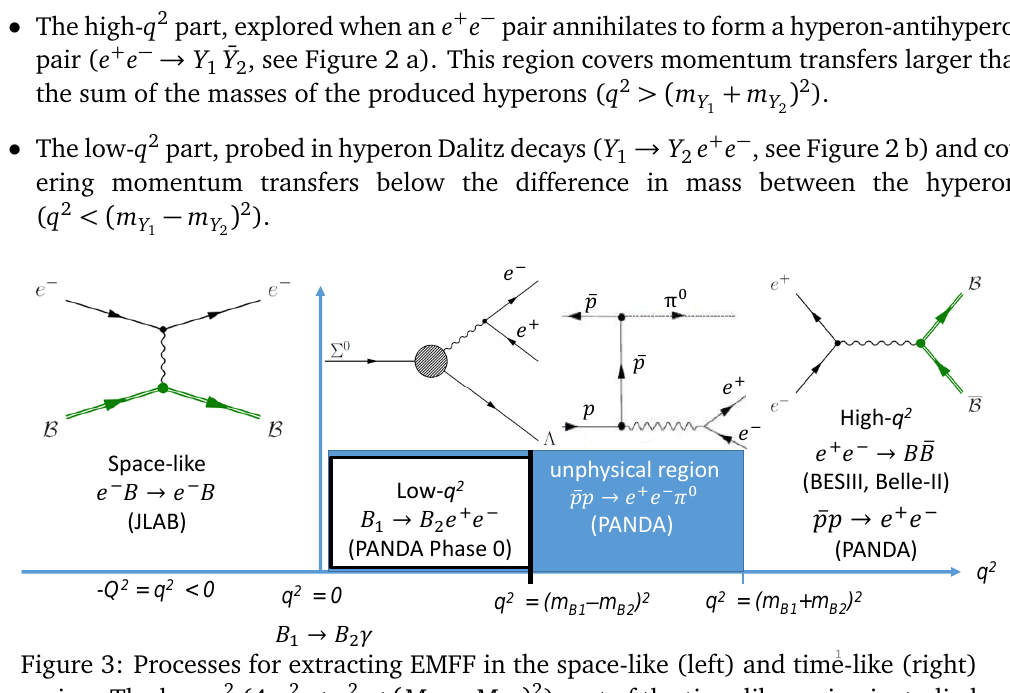
< q 2 < ( M − M ) 2 ) part of the time-like region is studied B 1 B 2 e < q 2 < ( M + M ) 2 ) by ¯ pp → (cid:96) + (cid:96) − π 0 B 1 B 2 e + M ) 2 ) by B ¯ B ↔ e + e − . Note that the B 1 B 2